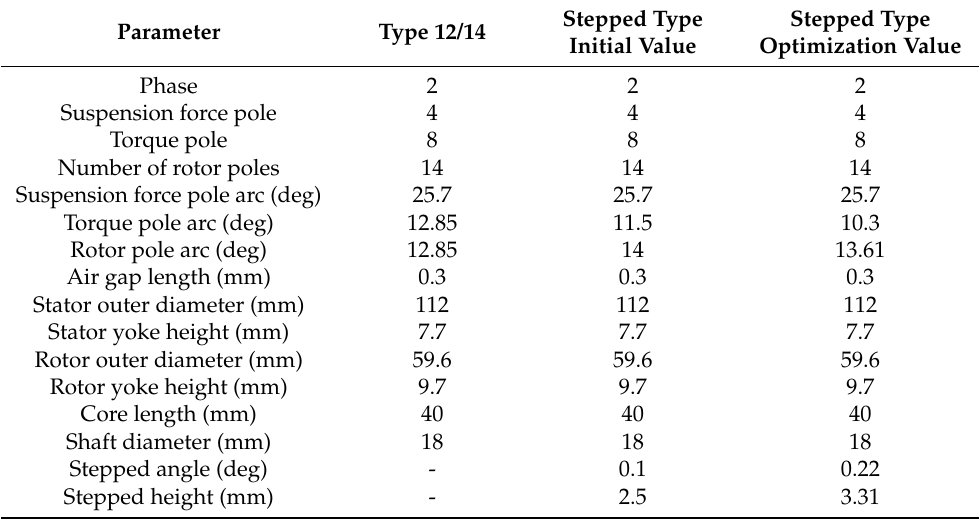
Table 2. Structural parameters of stepped rotor BLSRM before and after optimization.